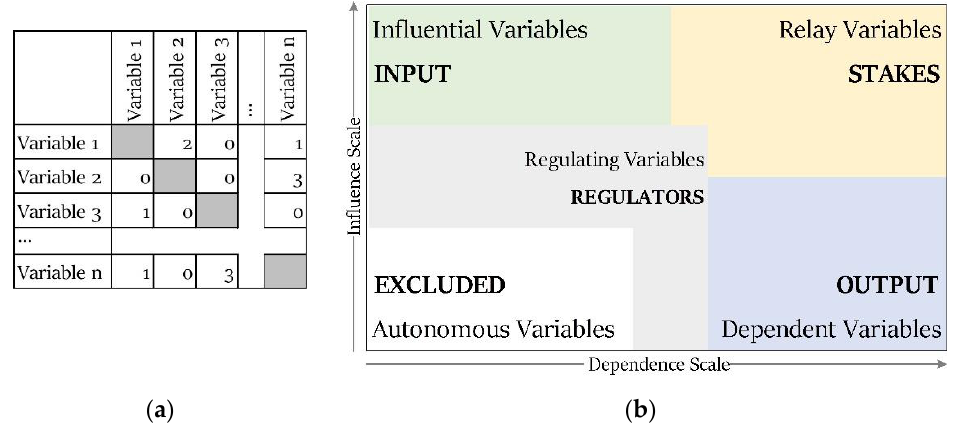
Figure 3. ( a ) Schematic illustration of a matrix of direct influence; ( b ) MICMAC influence-dependence map.